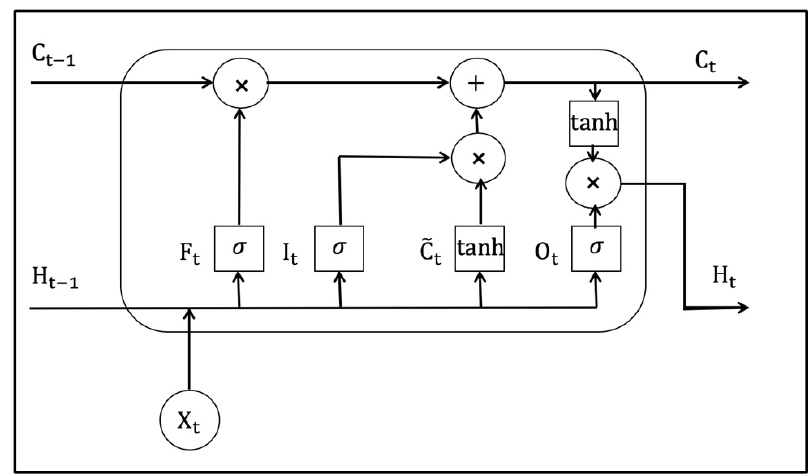
Figure 4. The internal structure of long short-term memory (LSTM) neural networks.